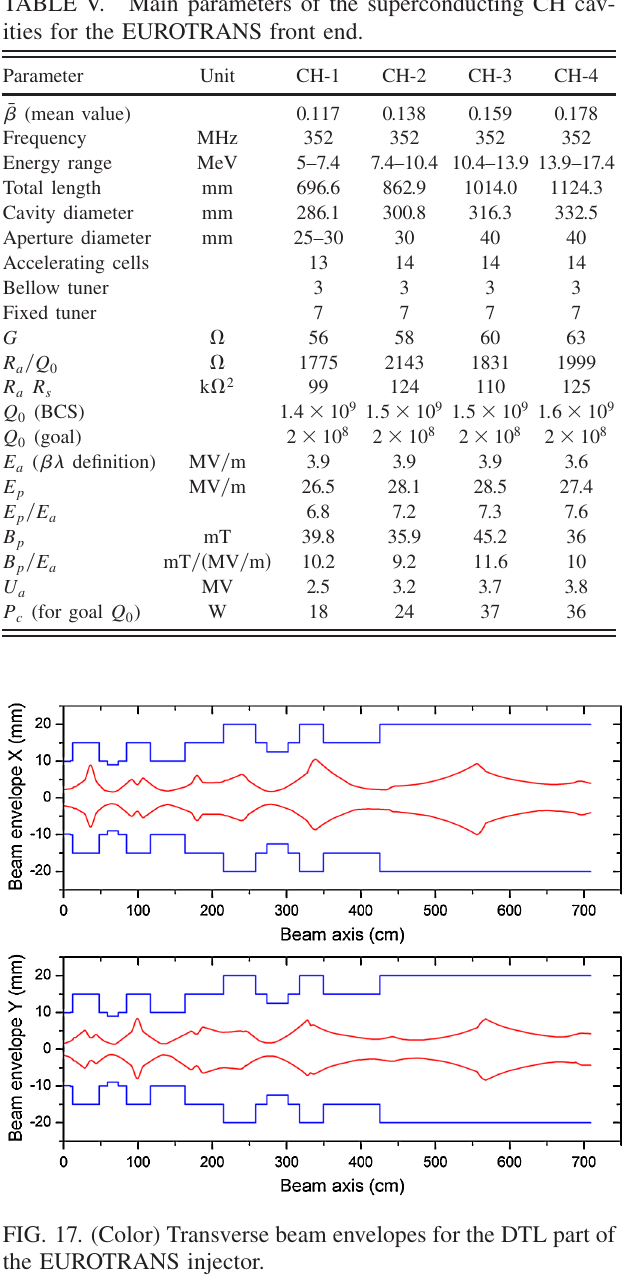
FIG. 17. (Color) Transverse beam envelopes for the DTL part of the EUROTRANS injector.